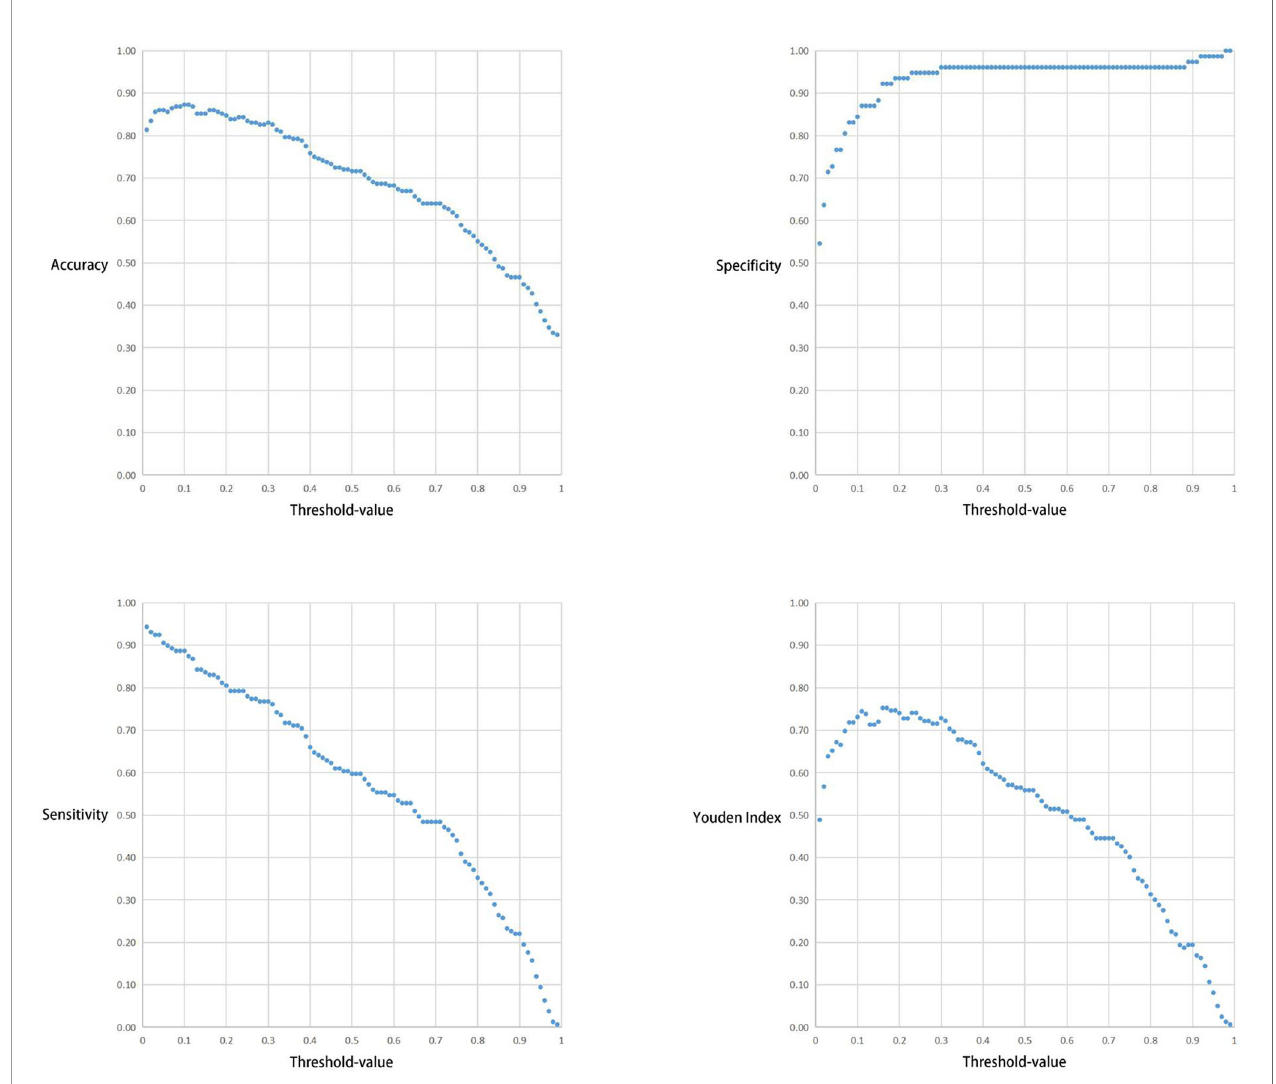
FIGURE 6 | Respective curves of Threshold-values versus Accuracy, Sensitivity, Speci fi city and Youden Index in Test Set